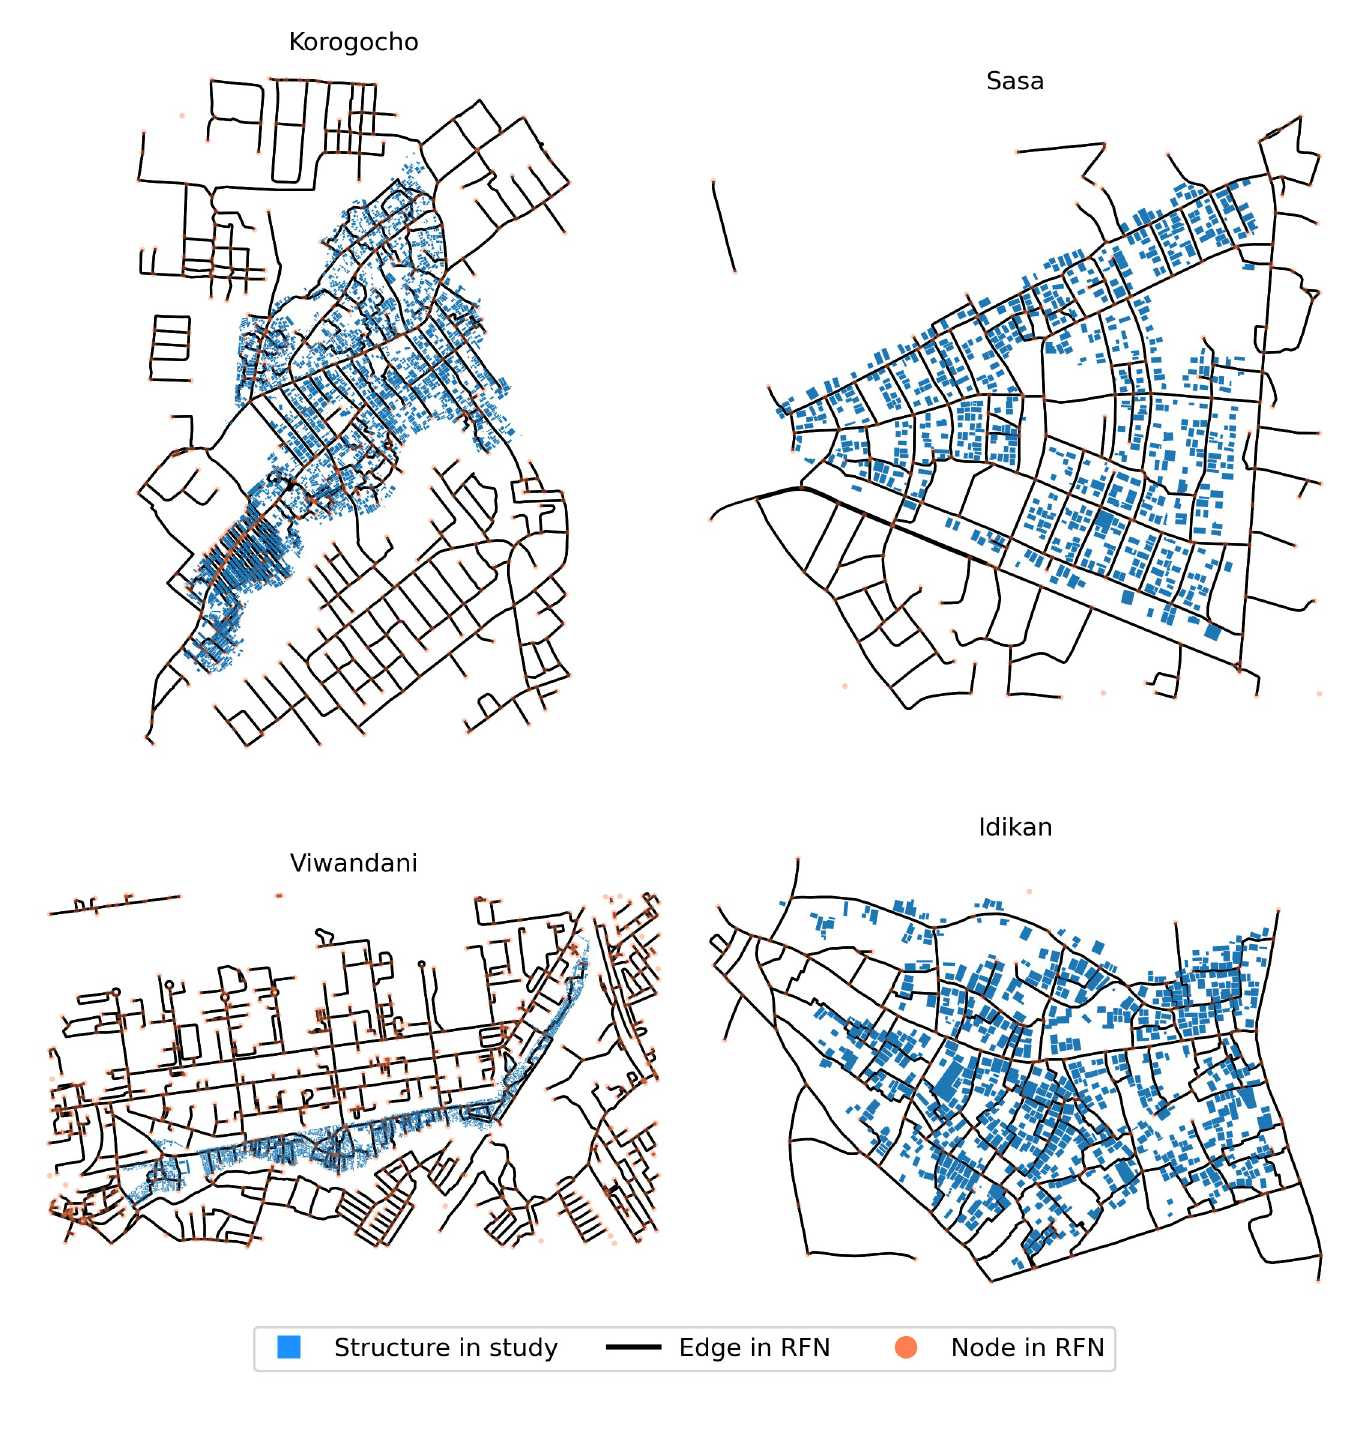
Fig 2. Road and footpaths networks provided by OSM [20] overlaid with dwellings for each slum.